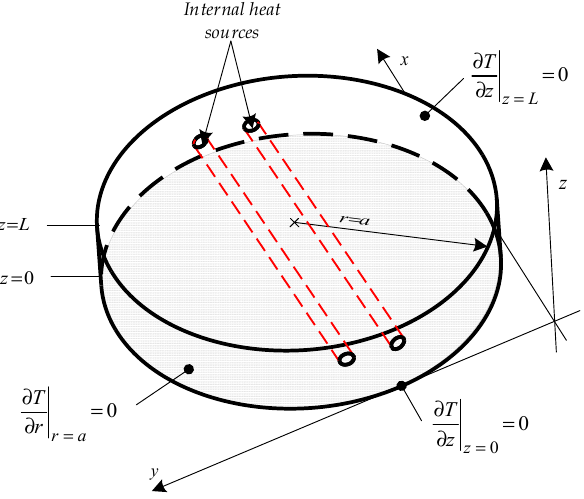
Figure 2. Boundaries that were applied to the experimental setup.